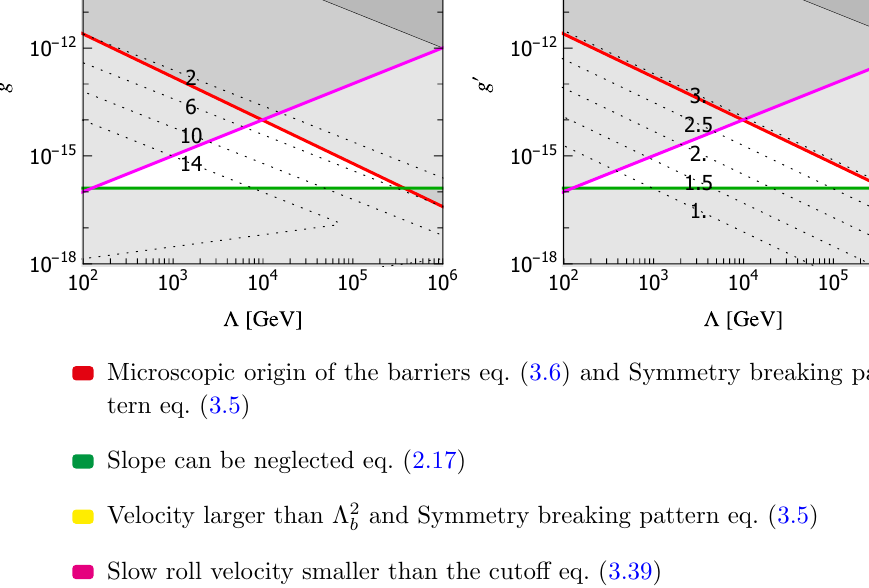
( f max ) (left) and 10 and f min = (cid:3), EW